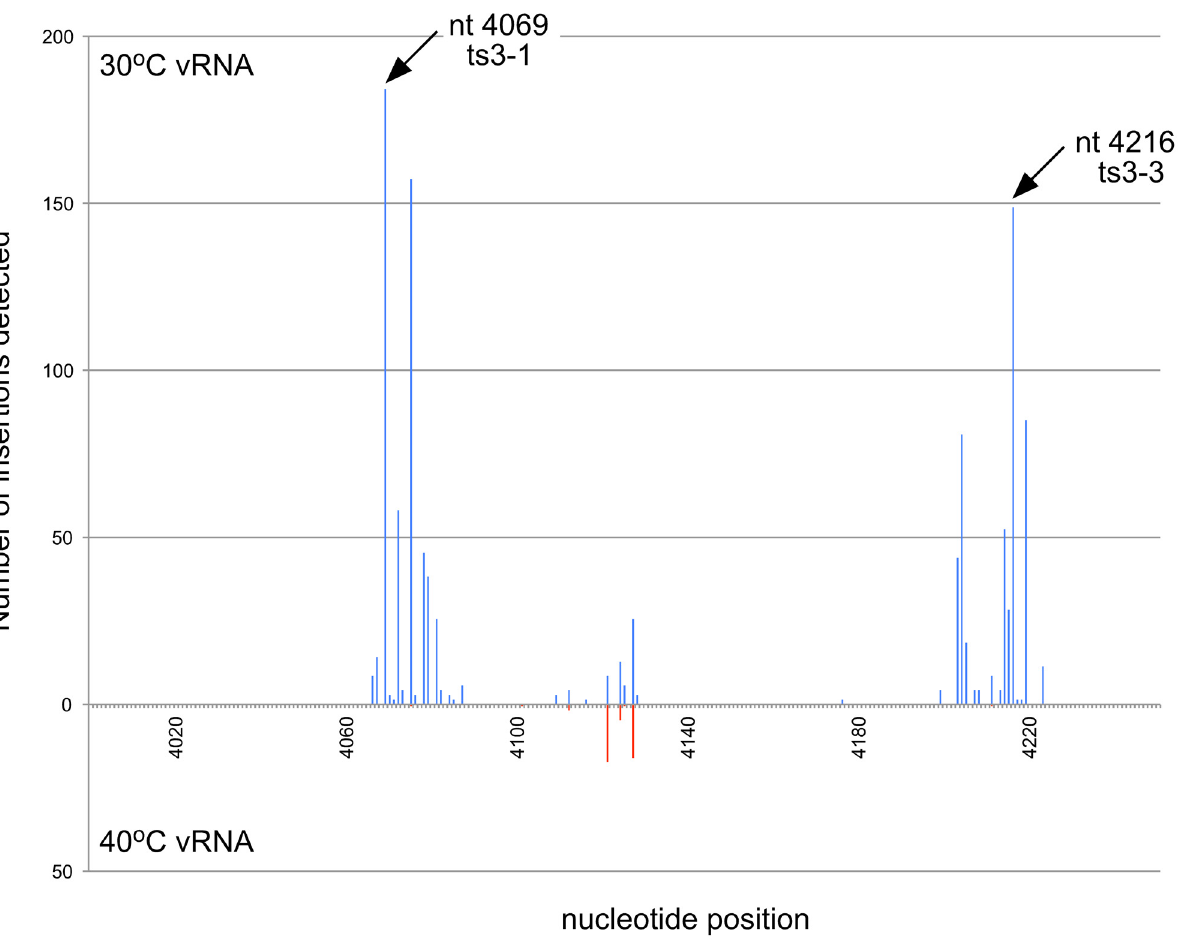
Figure 5. Location of nsP3 temperature sensitive mutants. The frequency of insertions at nt positions 4000–4250 at 30 u C and 40 u C is shown. The location of the ts mutants that were generated for the mouse challenge study are indicated with arrows. Mutants used in the study had either a single insertion at one of these locations (ts3-1 and ts3-3) or an insertion at both of these locations (double ts).